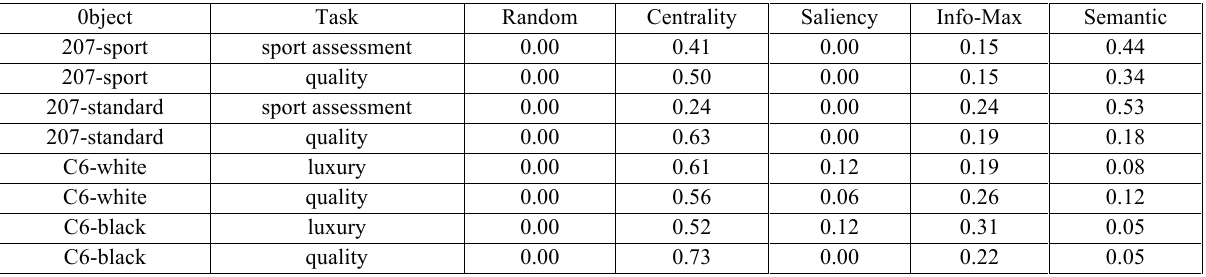
Table 2: Contribution of each factor for each experimental condition (judgment tasks).